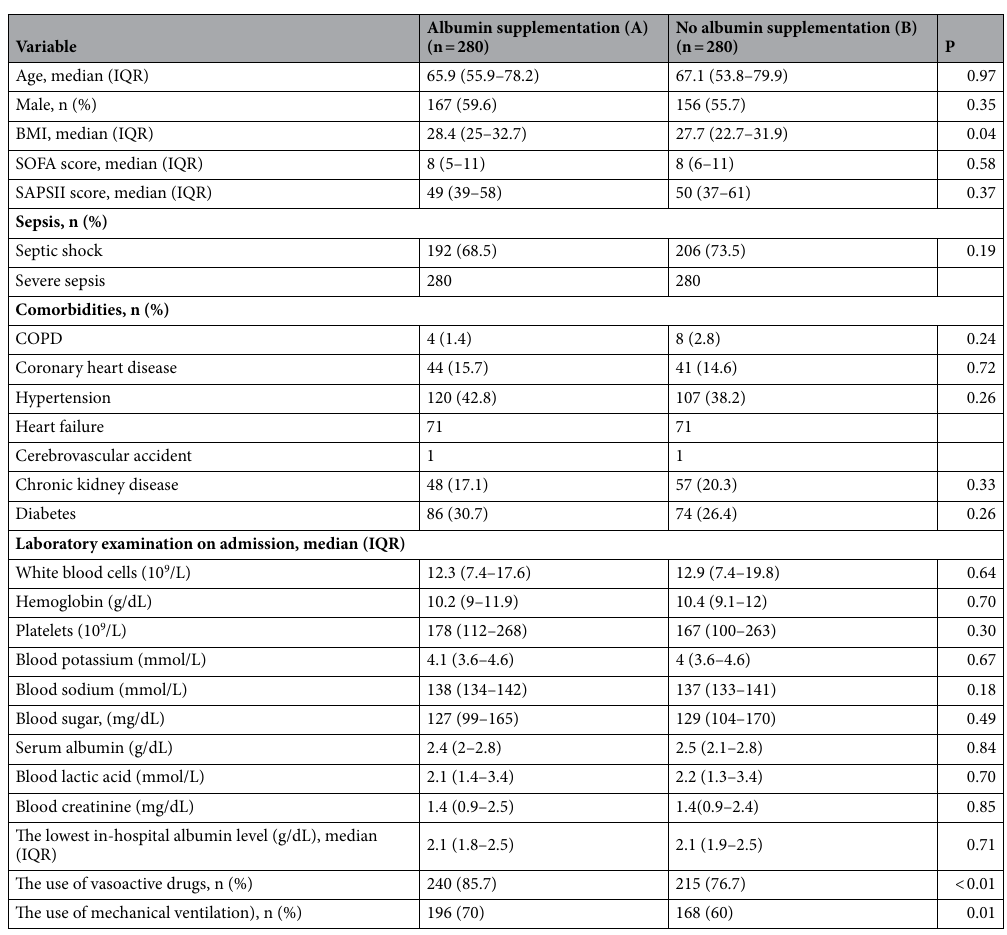
Table 4. Baseline situation of the two groups with and without albumin supplementation after propensity matching analysis.